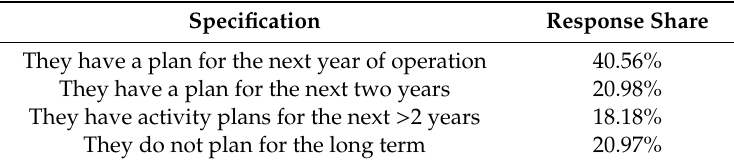
Table 4. Distribution of responses regarding the plans for investments in renewable energy sources (N =